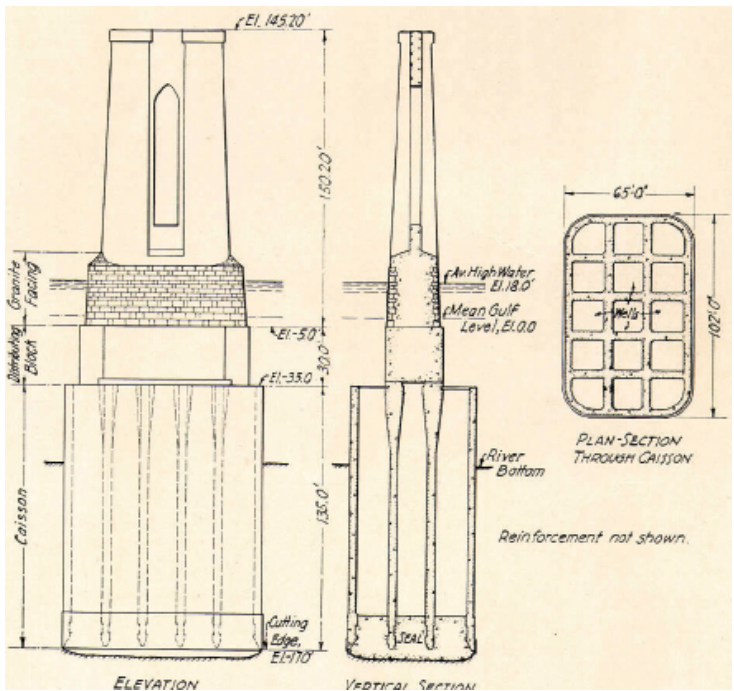
Figure 4. The various components of